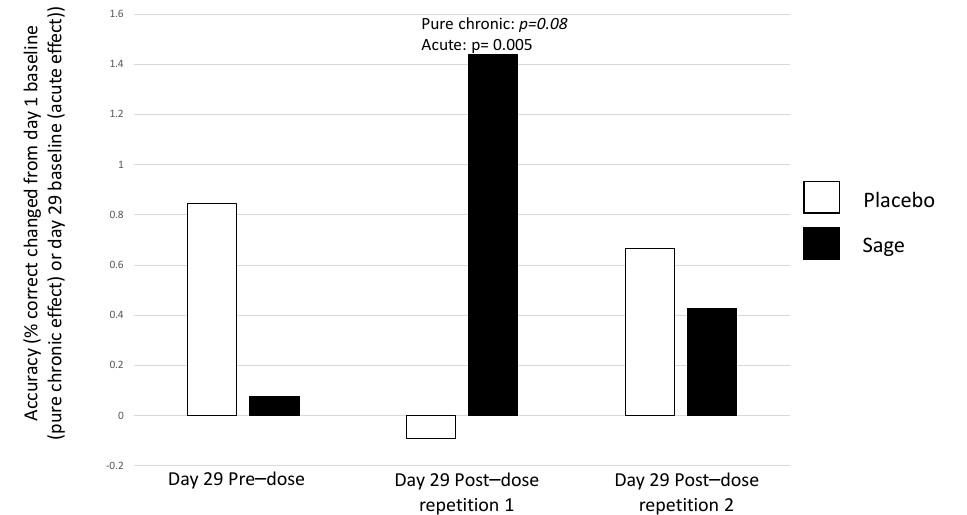
Figure 7. Acute (day 29) and pure chronic interaction between treatment × repetition on numeric working memory accuracy: both an acute interaction ( p = 0.04) and pure chronic interaction ( p = 0.01) between treatment × repetition was observed on day 29. Both revealed that this effect took place at post-dose repetition 1; the acute effect compares this post-dose repetition to the day 29 pre-dose performance ( p = 0.005) and the pure chronic effect compares this post-dose repetition to the day 1 baseline ( p = 0.08).